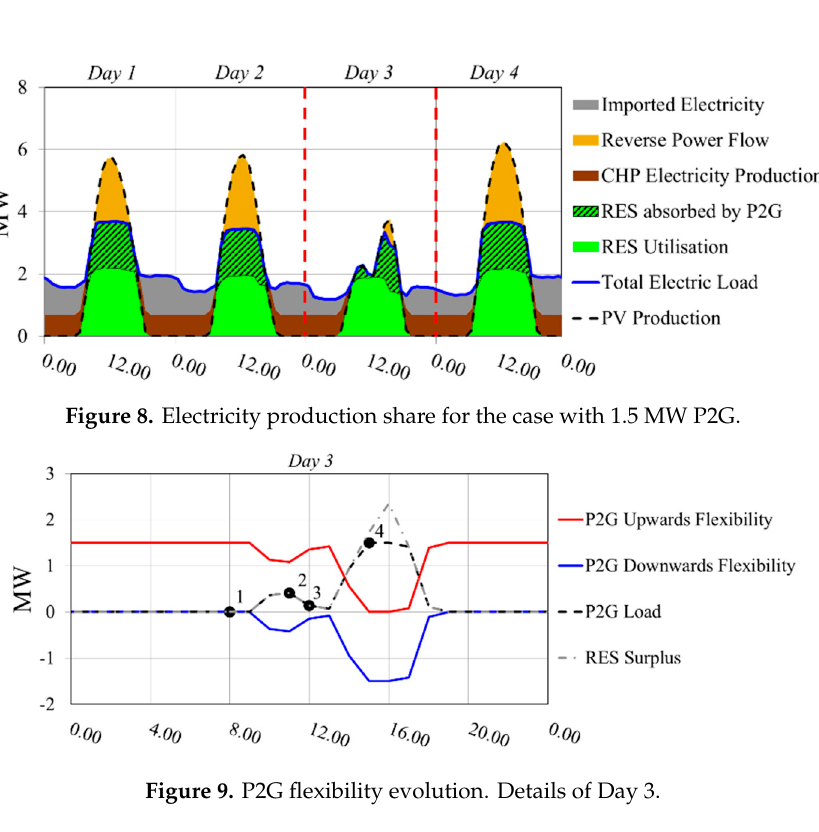
Figure 7. Electricity production share for the case with no P2G.